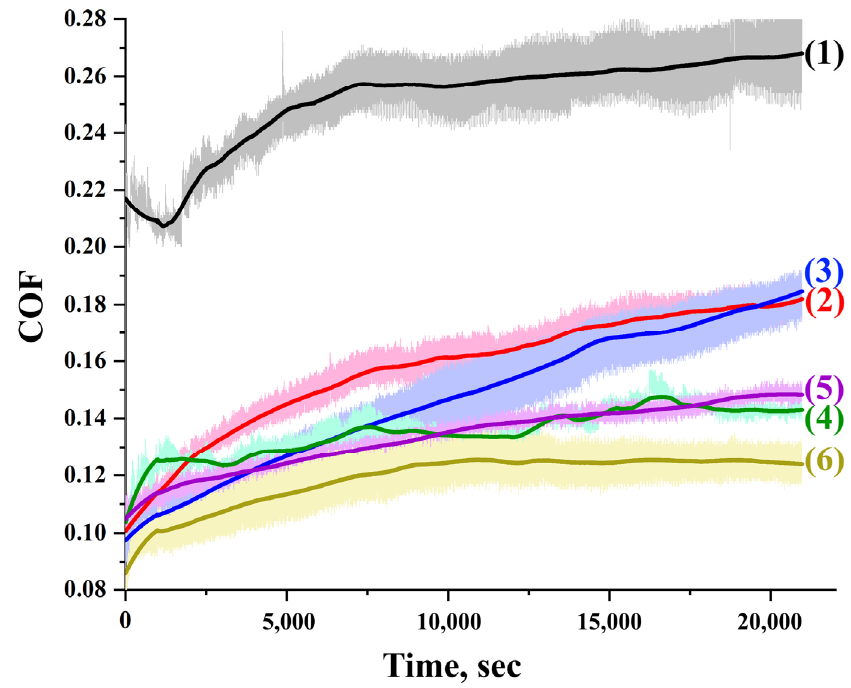
Figure 9. Coefficient of friction curves for isotropic and oriented UHMWPE films with different GNP/PANI contents. (1) isotropic UHMWPE, (2) oriented UHMWPE film, (3) oriented UHMWPE/1.0 wt. % PE-wax film, (4) oriented UHMWPE/1.0 wt. % PE-wax/0.01 wt. % GNP/PANI film, (5) oriented UHMWPE/1 wt. % PE-wax/0.5 wt. % GNP/PANI film, (6) oriented UHMWPE/1 wt. % PE-wax/2 wt. % GNP/PANI film. All samples were obtained by first thermal orientation regime.